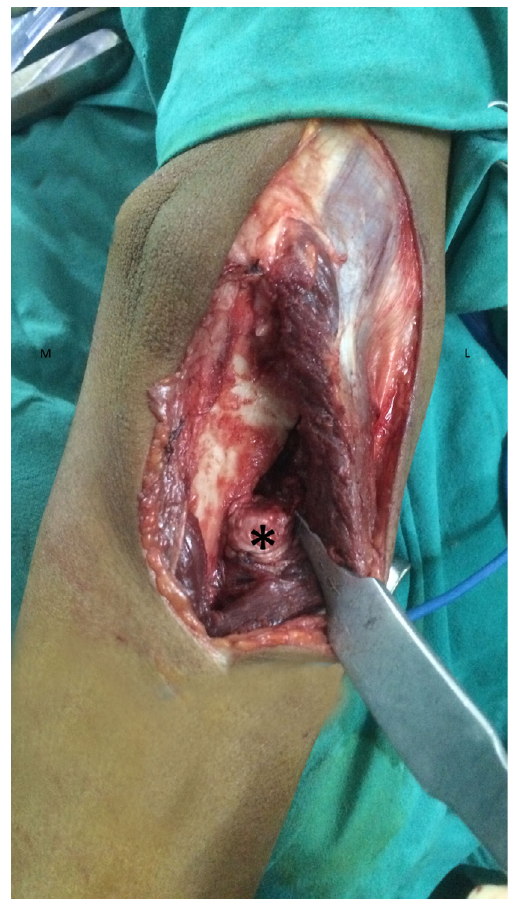
Figure 3. Intraoperative photograph showing excised synostotic site and coverage of osteotomized radial shaft with tensor fascia lata graft